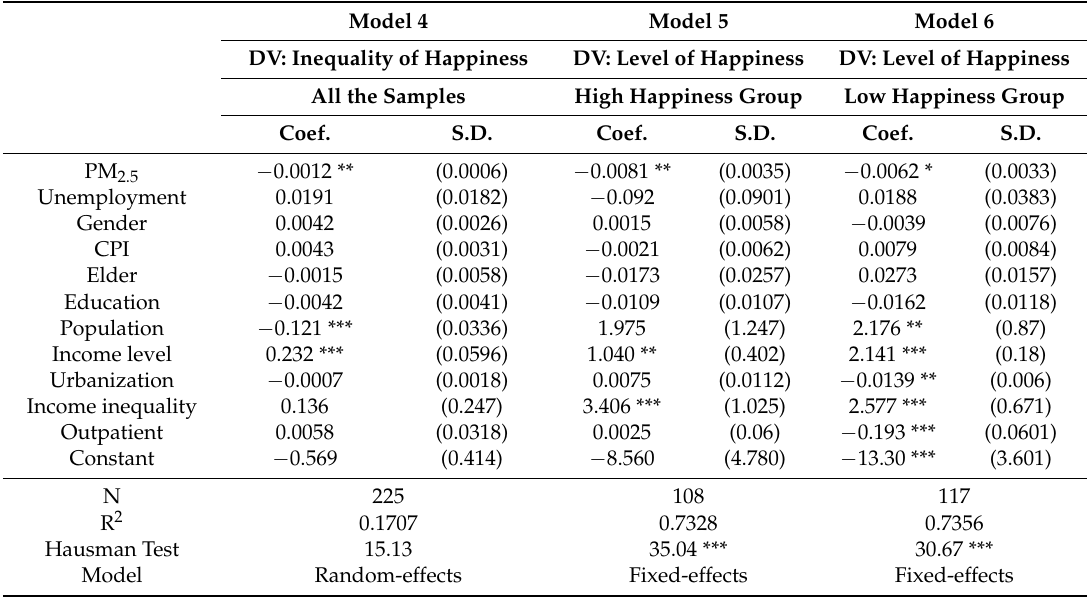
Table 3. Impacts of PM 2.5 concentrations on the inequality of happiness and the